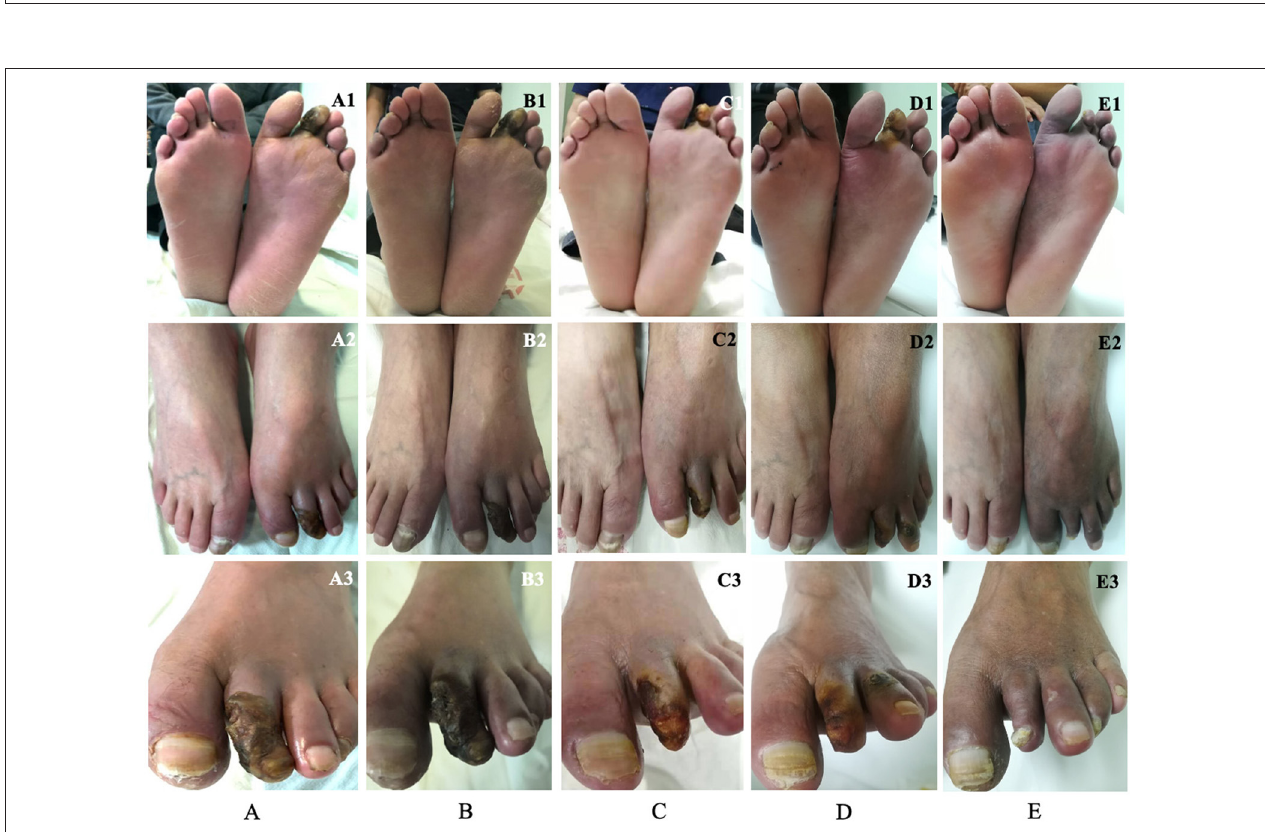
FIGURE 2 | A 55-year-old man was diagnosed with TAO and the progress of ulcer healing during the 12-month follow-up, which was photographed in three different angles. Before transplantation of PBMNCs, this patient presented gangrene in the second toe of the left foot (A) . The swelling around the gangrene and the rest pain decreased significantly at 1 month (B) . The pain disappeared, the necrotic tissue, and the toenail of the toe dropped at 3 months, only a little ulcer remained (C) . At 6 months, the remaining ulcer in the second toe was completely healed, and the patient returned to work. However, the ulcer appeared in the third toe (D) . The toenail of the second toe grew in again and the ulcer in the third healed completely (E) . TAO, thromboangiitis obliterans; PBMNCs, peripheral blood mononuclear cells.